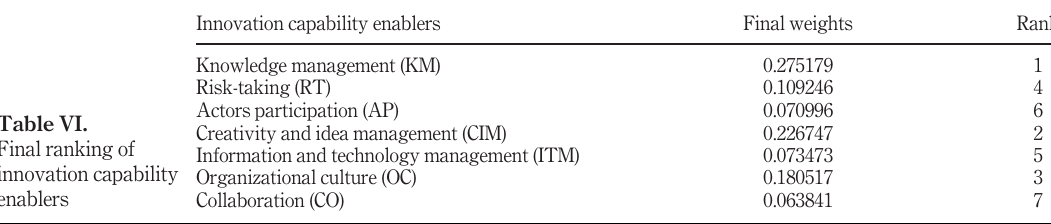
Table VI. Final ranking of innovation